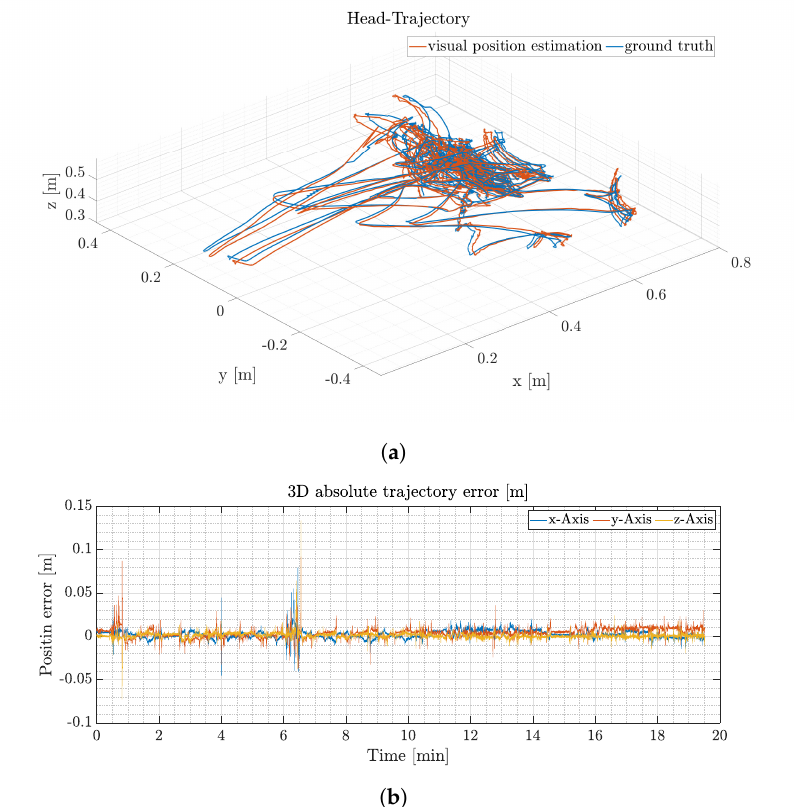
Figure 11. Results for head trajectory estimations for one trial: ( a ) Ground truth head trajectory measured with the Qualisys system (blue) and the position estimation based on visual position estimation (orange). Figure ( b ) depicts the corresponding absolute trajectory differences for each individual axis between ground truth Qualisys data and the visual position estimation. The maximum single axis error is 130 mm in the